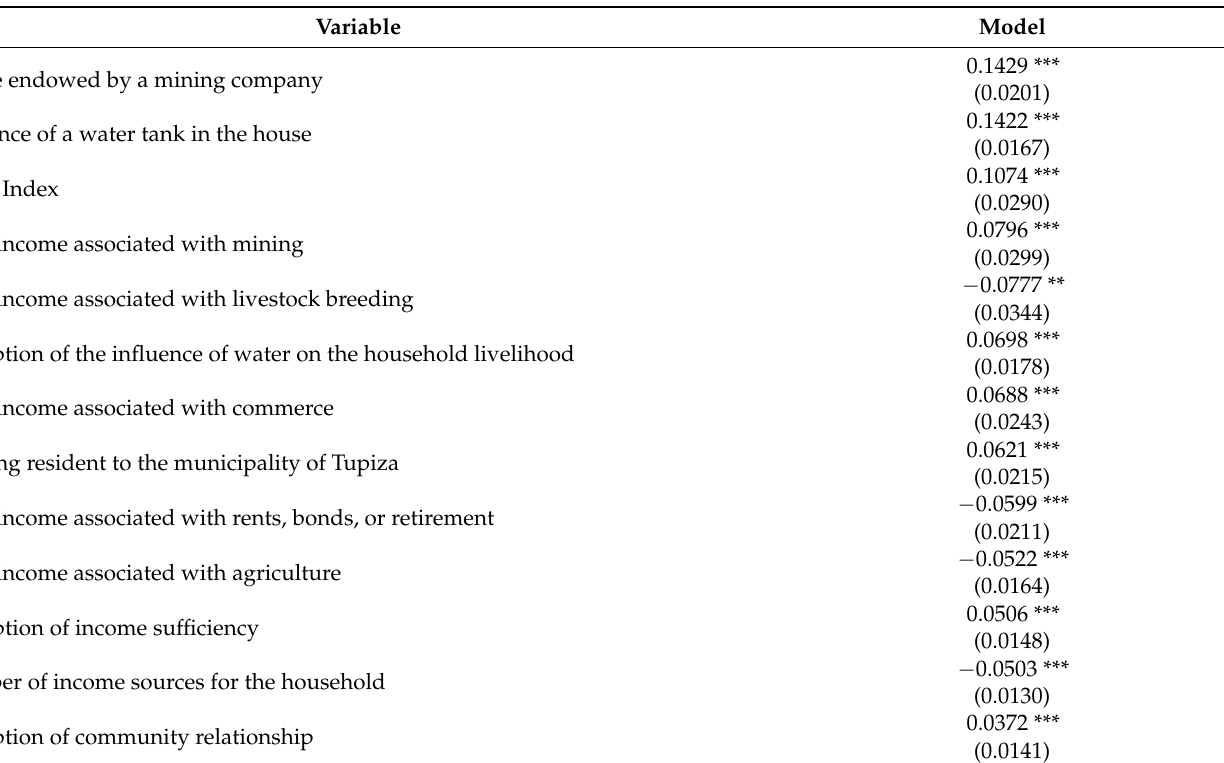
Table 8. Estimates of the poverty model for the rural area of the Tupiza River